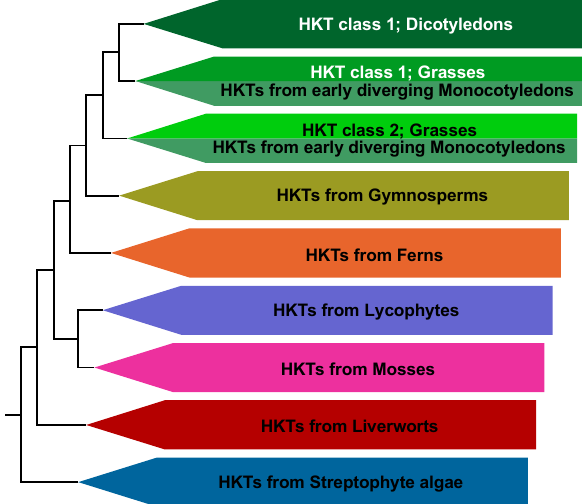
Figure 1. Condensed phylogeny of plant HKT channels. Evolutionary history derived from the phylogenetic tree shown in Figure S1. While there was mostly a gradual evolution of HKTs until the occurrence of seed plants, in monocotyledon angiosperms they split into two sub-branches. Class 2 HKTs can only be found in monocotyledons, while HKTs of class 1 can be found in monocotyledons and dicotyledons.